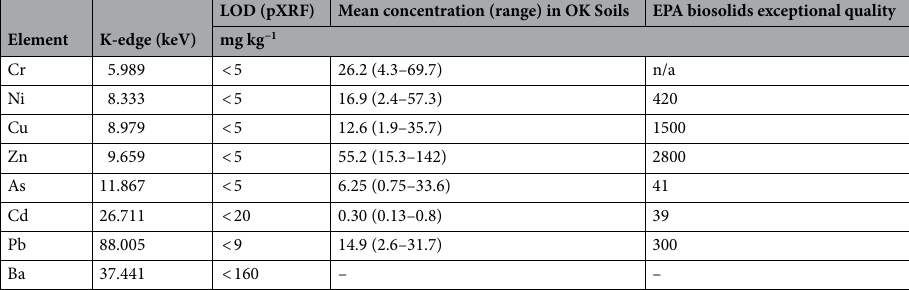
Table 2. Summary of elemental K-edge absorption energies that were scanned under 50 keV pXRF analysis settings, the limit of detection (LOD) of metals for the pXRF used, mean metal concentrations found in typical Oklahoma soils 31 , and EPA (Environmental Protection Agency) limits of metals for biosolids. pXRF portable XRF. n/a not applicable. “–”: not